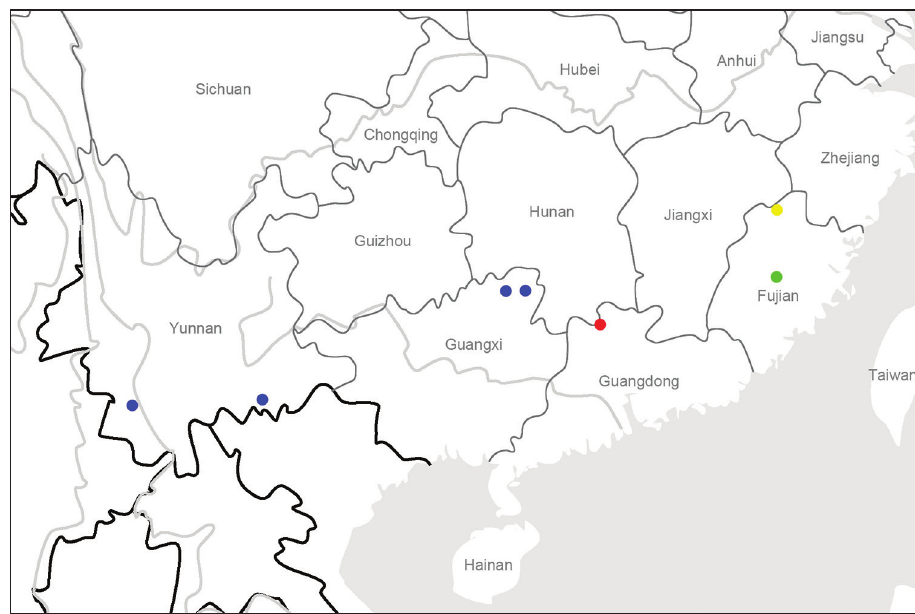
Map 1. Distribution map for L. auripennis sp. n. and allied species: L. auripennis sp. n. (red); L. fukiensis Jedlicka (yellow); L. wrasei Dubault, Lassalle & Roux (green); L. perniger Roux & Shi Legs: basal three metatarsomeres with distinct carina along almost full length of outer surface, fourth metatarsomeres with weaker carina only near base; fifth tarsomer- es with 3–4 pairs of spines ventrally. Male genitalia: median lobe of aedeagus with apical orifice opened dorsally; in lat- neither ventrally nor dorsally, basal portion slightly narrowed; in dorsal view, apical lamella very short, length approximately one-fourth basal width, apex rounded, slight- ly truncated; apical portion straight, oriented to neither left nor right. Endophallus (Fig. 4) short, extending to dorsal-left, major portion of endophallus on left-dorsal side of aedeagus when everted; gonopore ( gp , gonopore lobe folded in Fig. 4) located at a lit- tle before apical lamella, oriented to aedeagal apex. Basal tubercle ( bt ) typical of genus; basal band ( bb ) elongated, extended from apical orifice to base of lb . Six distinct lobes recognized: dorsal lobe ( dl ) very large and rounded, on right-dorsal surface; one ad- ditional basal lobe ( bl ) present on basal-ventral surface, close to dl , large and rounded, placed near apical lamella, decorated with very fine and sparse scales; right basal lobe ( rb ) a little smaller than dl , close to bl , apex sharply pointed, apex with dense and fine scales; right apical lobe ( ra ) on ventral side of gp , small, decorated with fine scales; left basal lobe ( lb ) a little larger than dl , on dorsal-apical surface, apex with dense scales; left apical lobe ( la ) small, close to lb , apex sharply pointing out, decorated with fine scales. Distribution. This species is known only in Nanling, Guangdong (Map 1). The three localities of the type series are very close together.